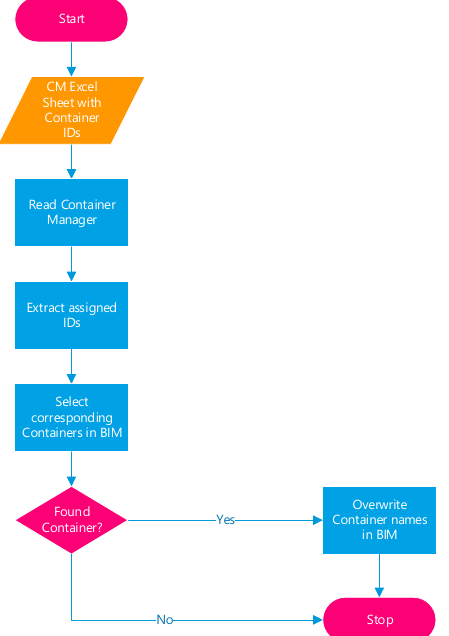
Figure 11. Assign container rental IDs algorithm.